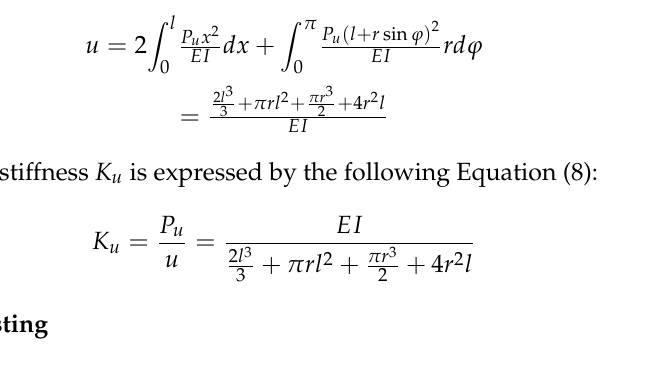
4 of 18 Figure 2. Horizontal direction. The displacement u of the action point P under the action of the horizontal load P u is expressed by the following Equation (7):